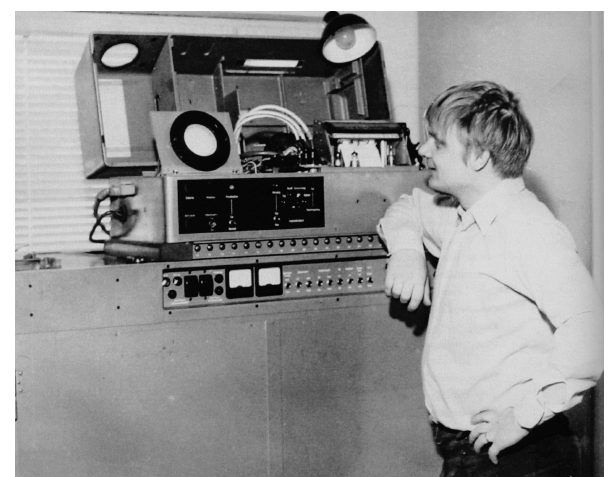
Figure 6. Tauno Turunen standing before the transmitter of the ionosonde in 1972 (photo supplied by